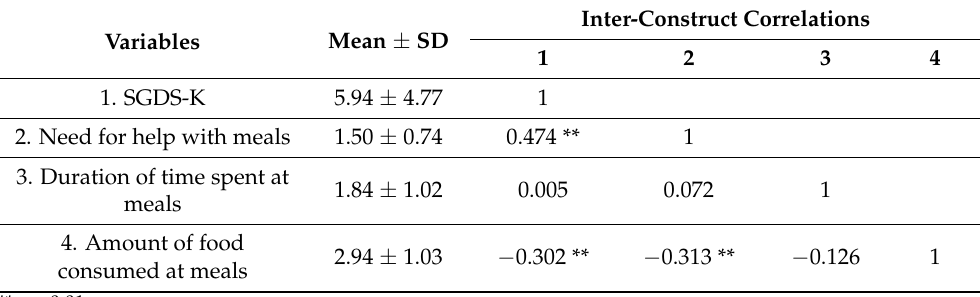
Table 8. Correlation between the Short-Form Geriatric Depression Scale for Koreans and Dietary Factors in the Dysphagia Group.